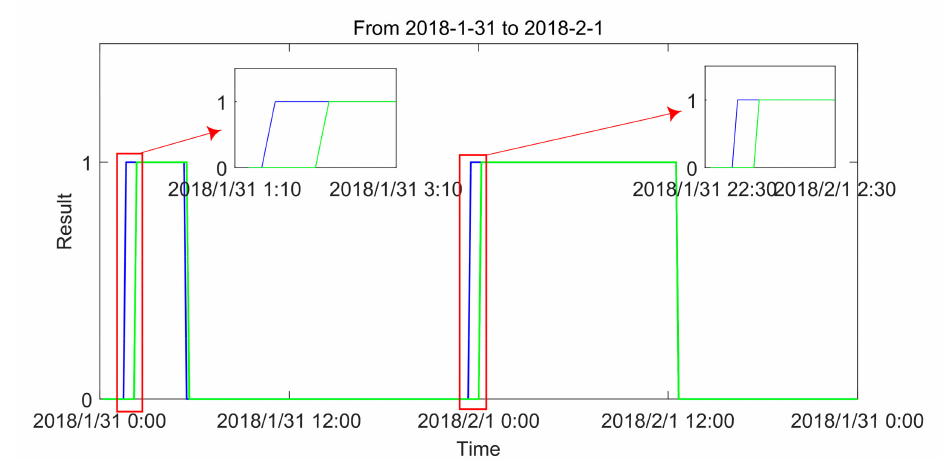
Figure 11. Comparison of timeliness of FCNN–MSE method and the original system for blade icing detection (The blue line represents the detection result of the FCNN–MSE method, while the green line represents the detection result of the original